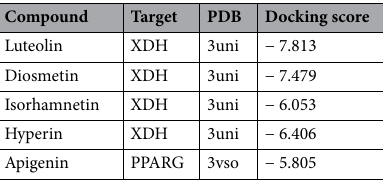
Table 1. Docking score results of the Schrodinger docking compound.